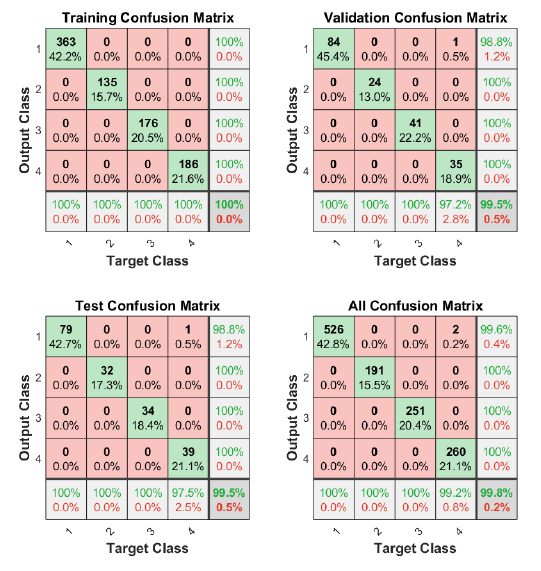
Figure 16. Neural network training confusion